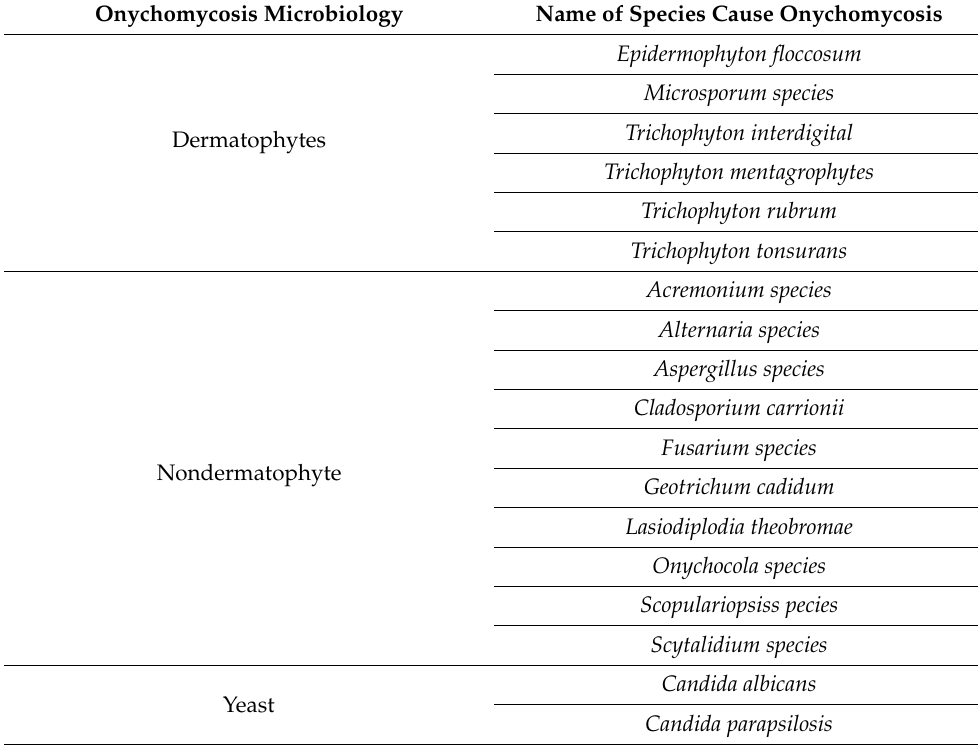
Table 3. Most common fungal agents for the treatment of